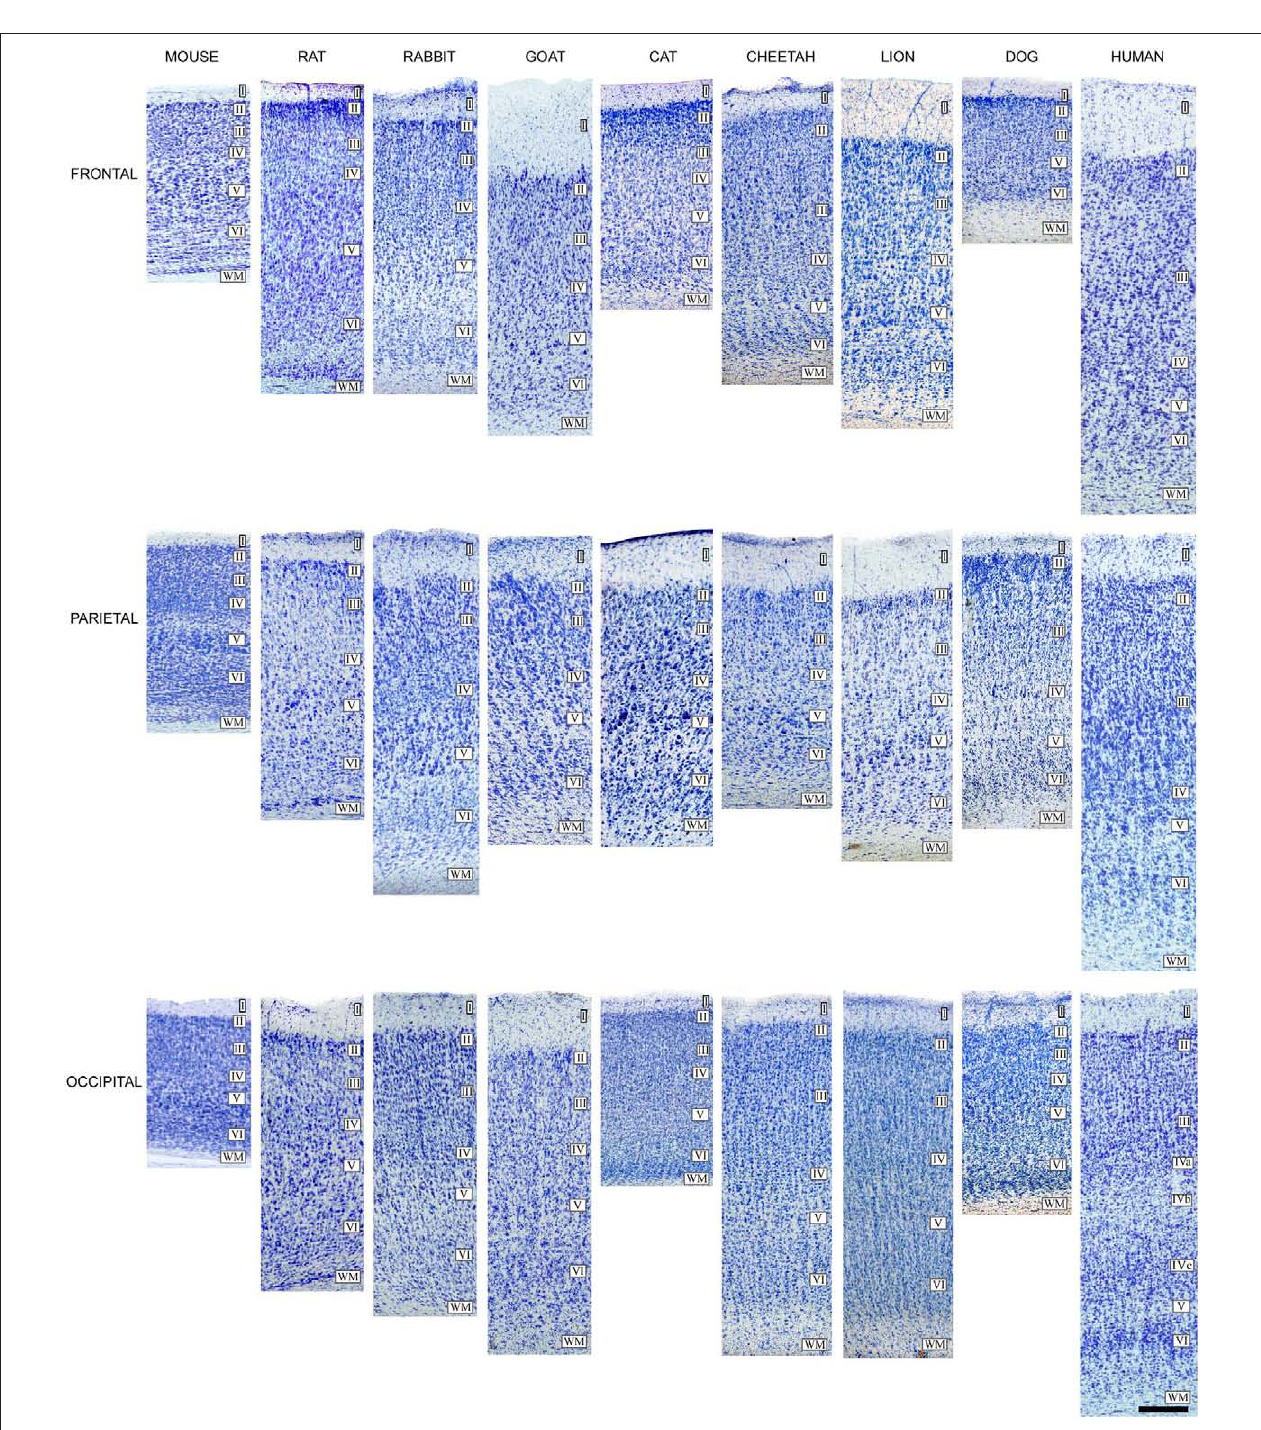
Figure 8 | Cytoarchitectonic differences in the mammalian cortex. Photomicrographs from 100 μm thick Nissl-stained sections showing some cytoarchitectonic differences between frontal, parietal, and occipital cortical areas of the human (areas 10, 3b, and 17, respectively) and several mammals. Scale bar: 250 μm. Adapted from Ballesteros-Yánez et al. (20